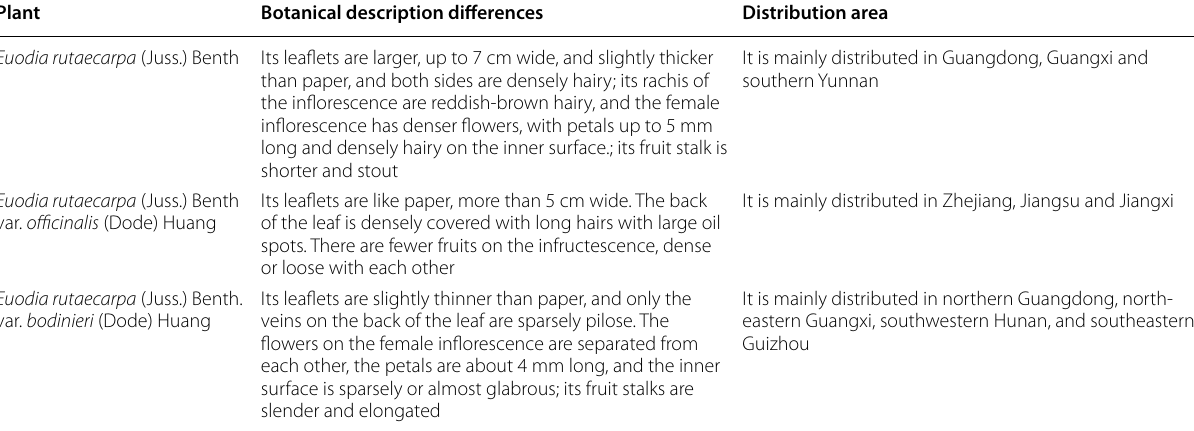
Table 1 The differences in botanical descriptions between three plants Plant Botanical description differences Distribution